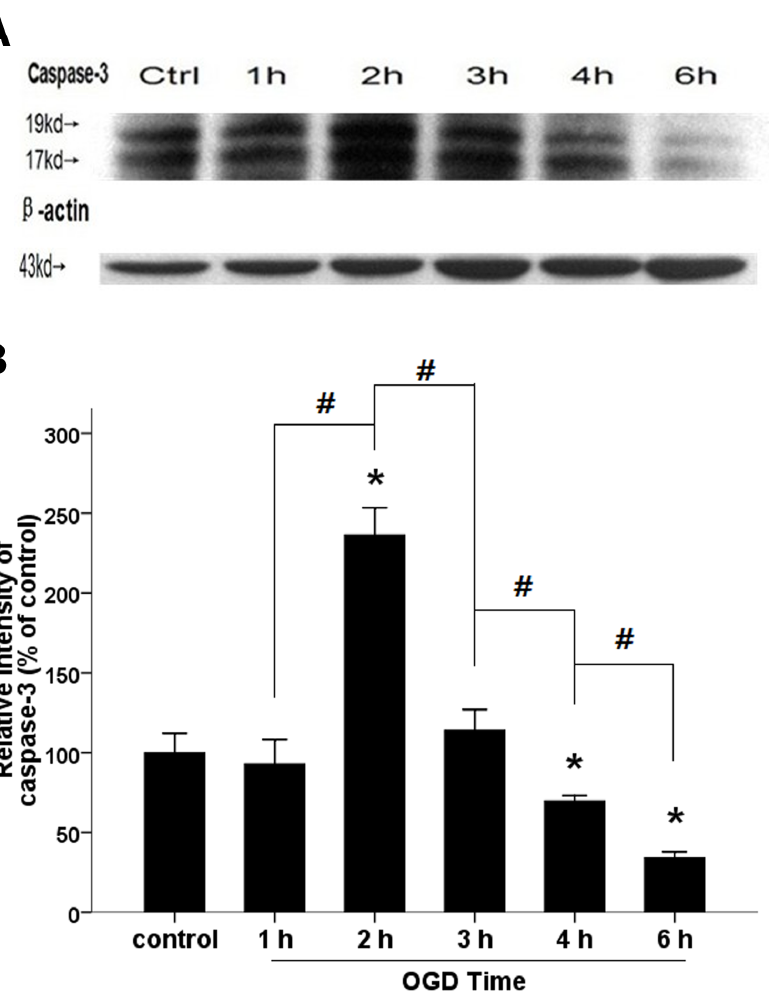
Figure 5. Western blot about active caspase-3. (A) Representative Western blot for active caspase-3 in astrocytes exposed to mixed OGD for 0 h (Ctrl), 1 h, 2 h, 3 h, 4 h and 6 h. (B) Relative density of the proteins measured by quantity one. Data are expressed as the mean 6 SD; (*) indicates a significant difference (P , 0.05) from the control group; ( # ) indicates a significant difference between two adjacent OGD time points.